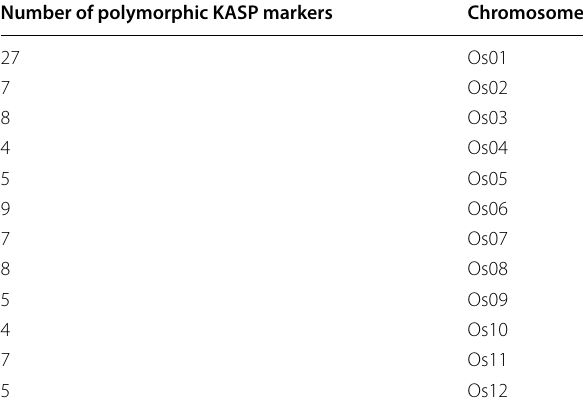
Table 1 Distribution of the KASP markers used in the background selection on the 12 rice chromosomes